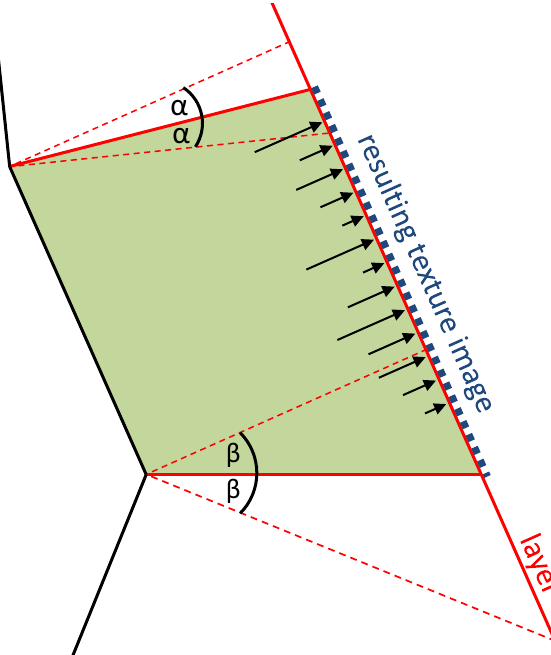
Figure 7. Buffer and texture image generation (top down view)